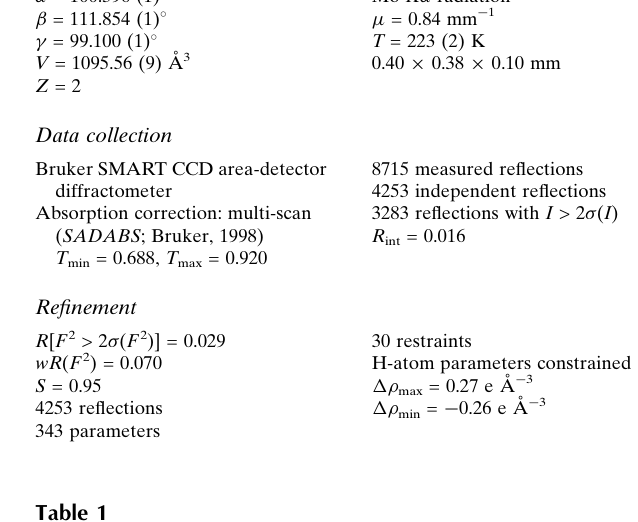
Selected geometric parameters (A˚